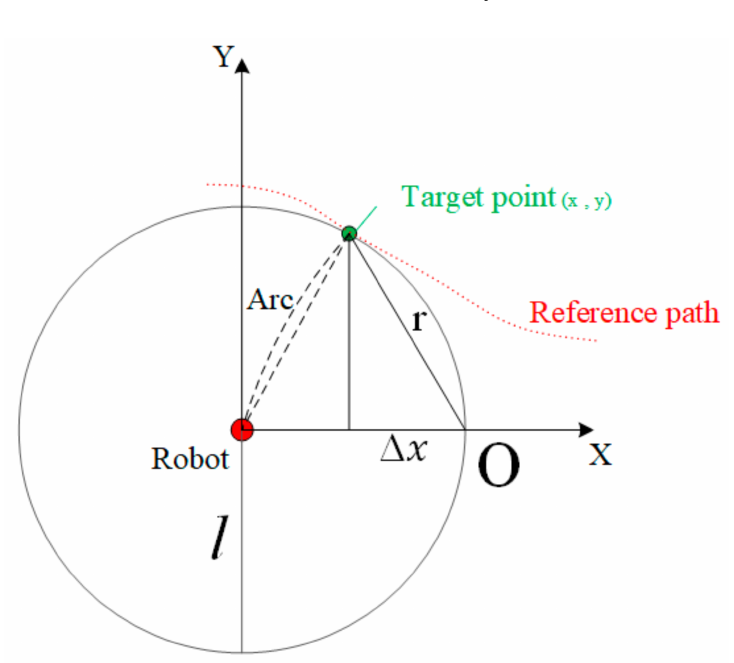
Figure 11. The principle of pure